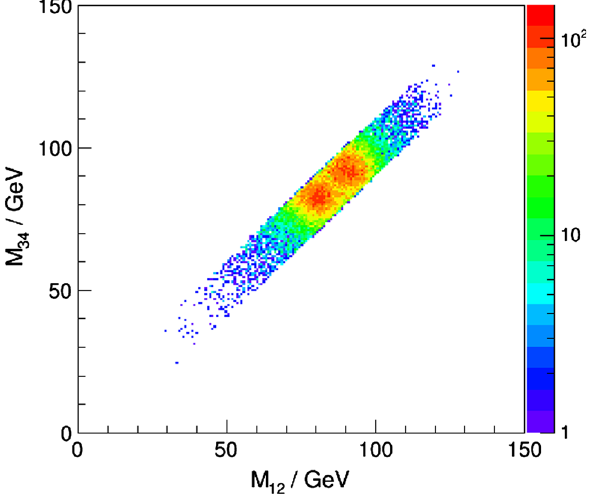
Fig. 9 TheRecoJetleveldistributionof M 12 versus M 34 withtheequal mass condition. The selection efficiency for WW/ZZ is 54%/44%